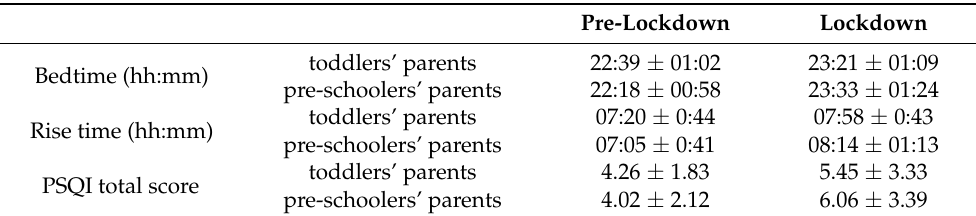
Table 4. Sleep schedules and sleep quality before and during the lockdown in toddlers’ and pre- schoolers’